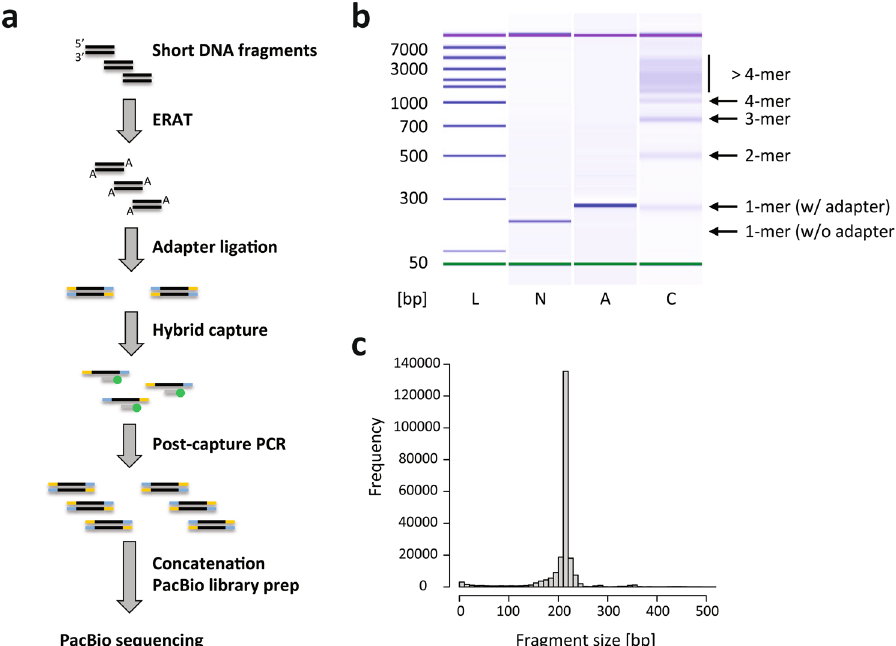
Figure 4. Adaptation of Concat-Seq to an alternative target enrichment workflow. ( a ) Schematic of Roche Nimblegen’s SeqCap workflow and its adaptation to ConcatSeq. Short DNA fragments, for example cell-free DNA, are prepared for adapter ligation by end-repair and A-tailing (ERAT). During adapter ligation, two types of ConcatSeq adapters are used (blue and yellow portions) instead of the Y-shaped adapters normally used in this step. The resulting library pool is then used for hybridization to biotinylated (green dots) hybrid capture probes (gray bars), and enriched targets are subsequently amplified in a post-capture PCR. The amplified material is then concatenated and processed as described in Fig. 1a. ( b ) Bioanalyzer DNA7500 gel image showing ladder [L], the non-concatenated amplicon pool (a pool of 4 amplicons from the EGFR locus) [N], the non-concatenated amplicon pool with adapters [A], and the concatenated sample [C]. As expected a shift of about 60 bp was observed between lanes [N] and [A] indicating successful ligation of ConcatSeq adapters to the original pool of amplicons. Banding pattern in lane [C] indicates depletion of monomers and accumulation of n-mers of higher degree. ( c ) Histogram depicting frequencies of fragment lengths after deconcatenation of EGFR-concatemer reads. The size of the vast majority of fragments coincides with the expected EGFR amplicon length (220